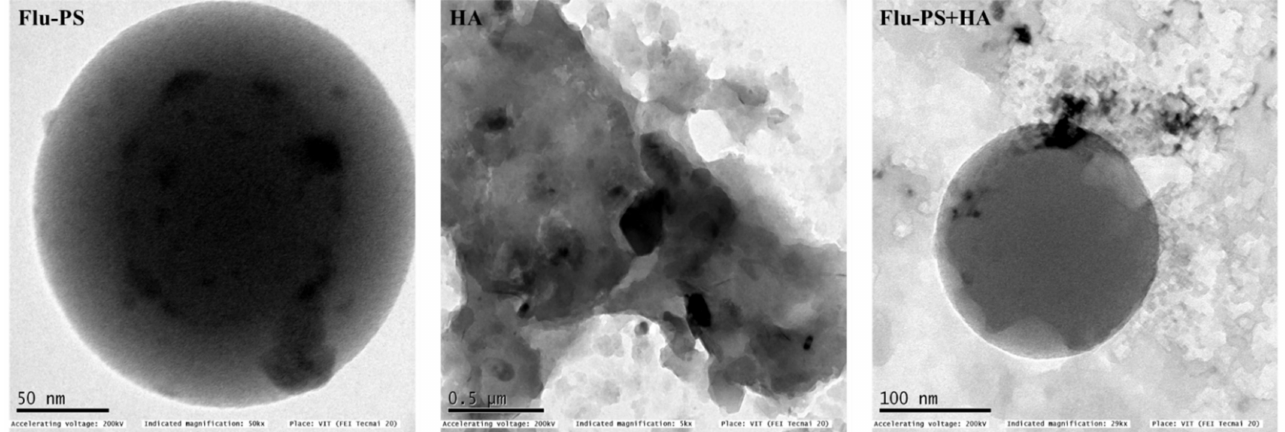
Figure 1. Transmission electron microscopy (TEM) image of Flu − PS, HA and Flu − PS+HA dispersed in deionized